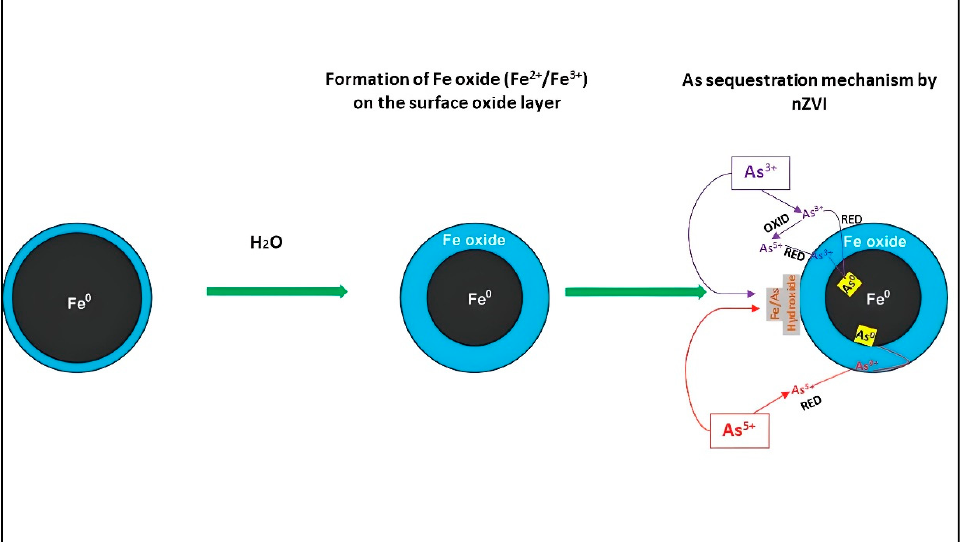
Figure 1. Main reaction mechanisms for the removal of As 3+ and As 5+ by nZVI. Adapted from Rashid et al., 2020 [33]; Singh et al., 2021 [34]; Ahmed et al., 2021 [35] .